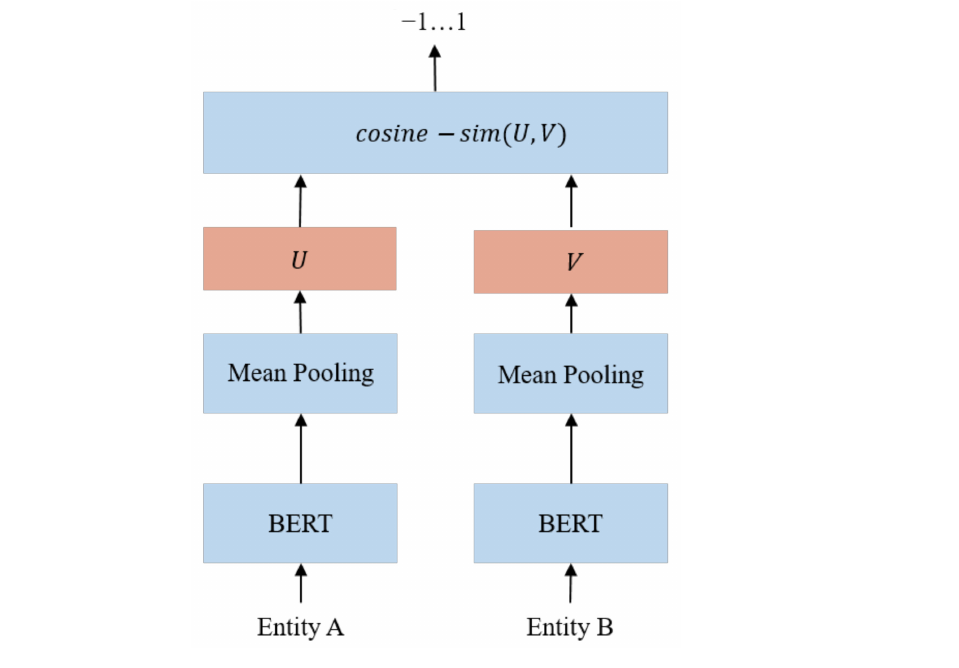
Figure 3. Architecture of the SBERT model.